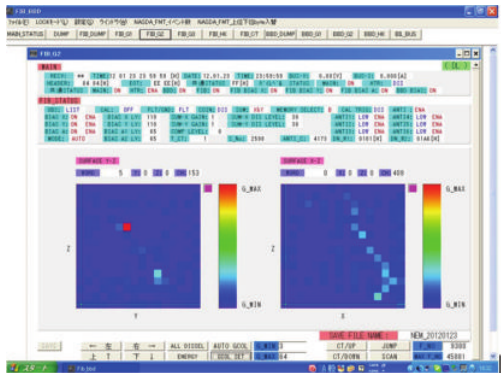
Figure 8: A candidate electron track. A photon enters from the top of the sensor ( y - z plane). An electron apparently deposited energy inside one vertical bar (where the red spot denotes a large deposit of energy) while running vertically, thus enabling the recording of a long thin track in the x - z plane. Since the ionization loss of electrons is smaller than that of protons, thin tracks are